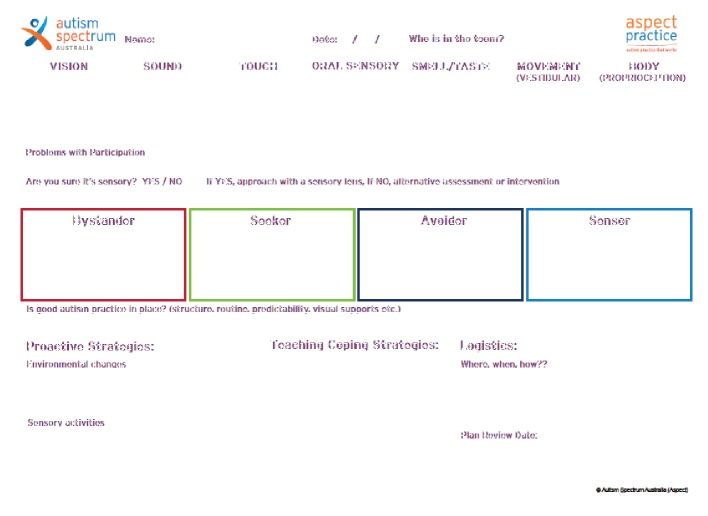
The Sensory Form.